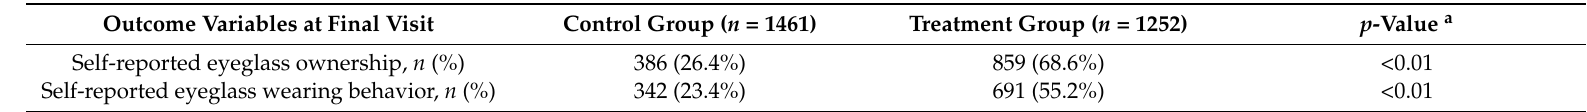
Table 2. Self-reported Eyeglass Ownership and Wearing behavior by Study Group at Final Visit among 2713